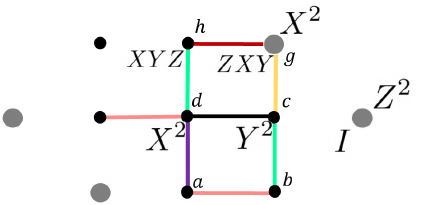
FIG. 28. Stabilizer constraint for the closed loop d → c → g → h → d , which gives − I , and it matches identity (C5) on the fermion side A e